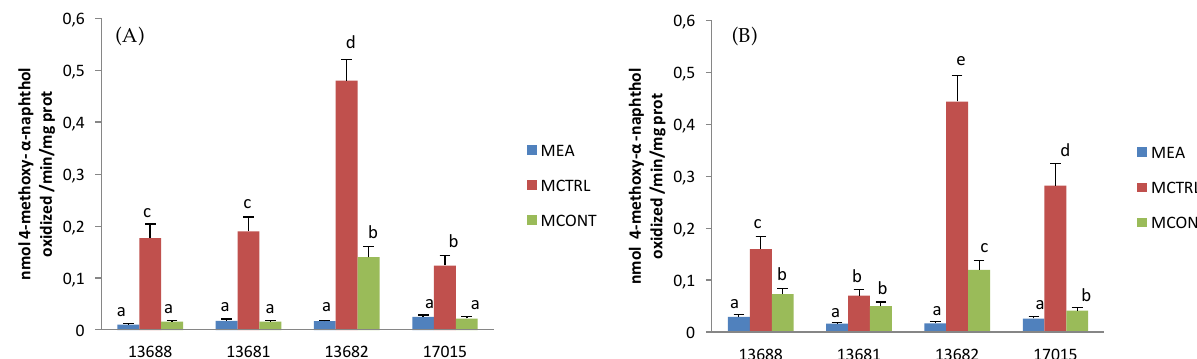
Figure 5. Soluble peroxidase (POD) activity in different strains of Pleurotus eryngii grown on agar (MEA), on agar contain- ing non-contaminated maize (MCTRL), or contaminated maize (MCONT), for 12 (A) or 20 (B) d. Values represent the mean of at least three replications from three independent experiments. Same letters over the columns indicate non-significant differences between treatments within each strain ( P <0.05, Duncan’s